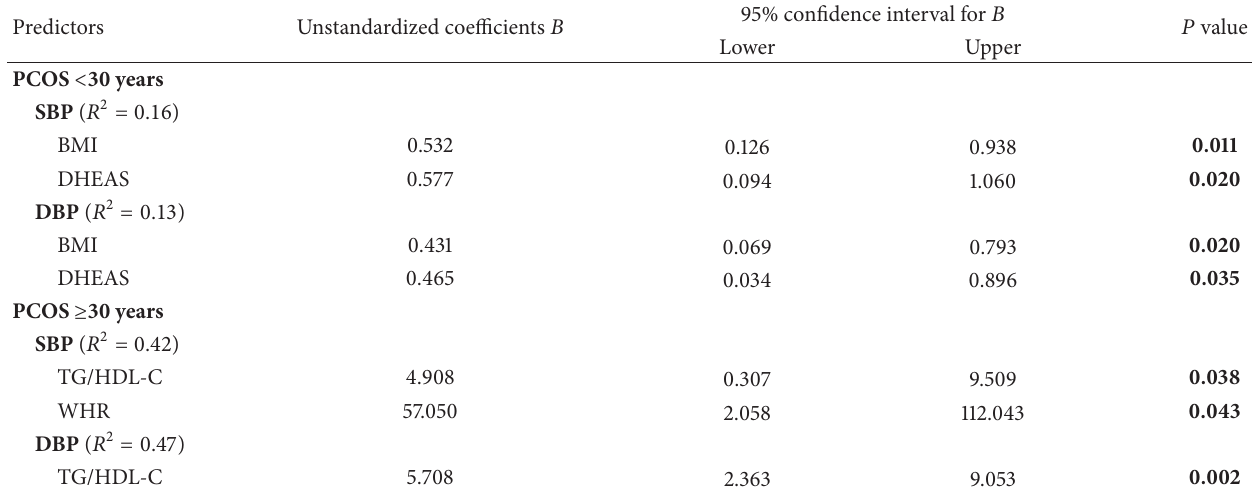
Table 3: Independent predictors of systolic and diastolic blood pressure in PCOS related to age.